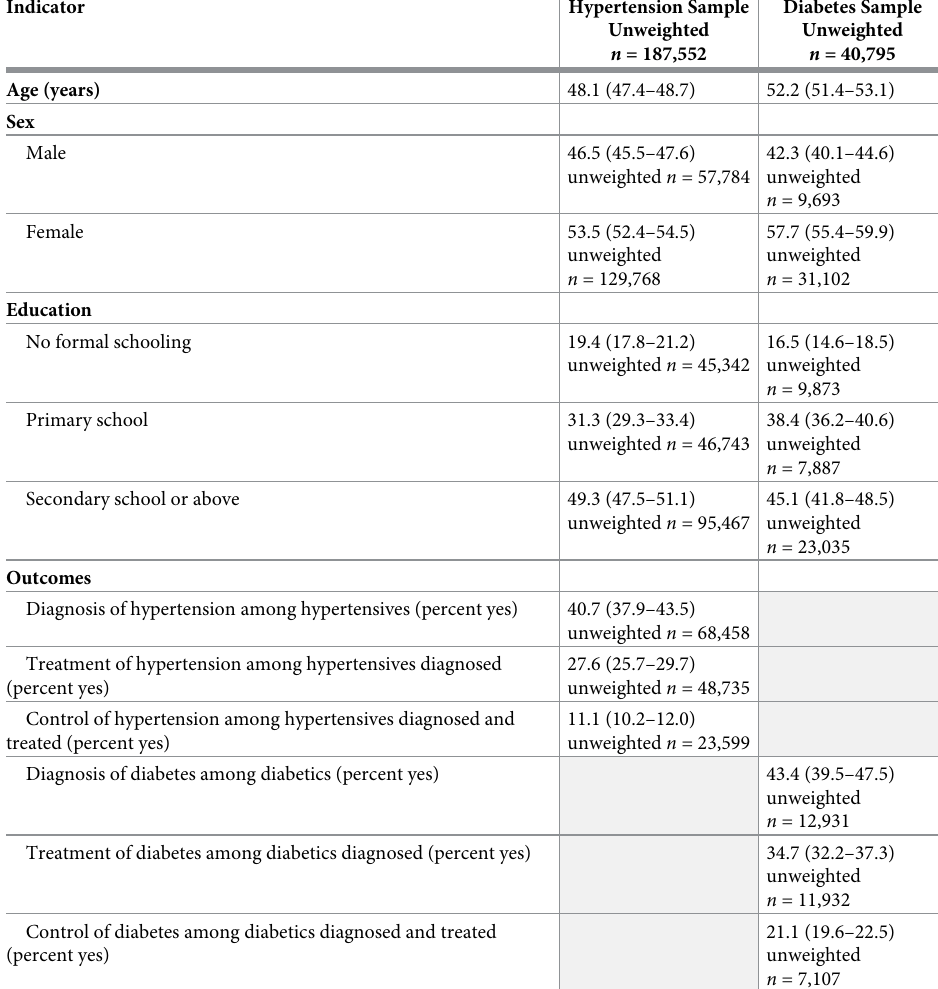
Table 3. Summary of individual-level data used in this analysis. The hypertension sample includes data from 43 countries, and the diabetes sample includes data from 28 countries.